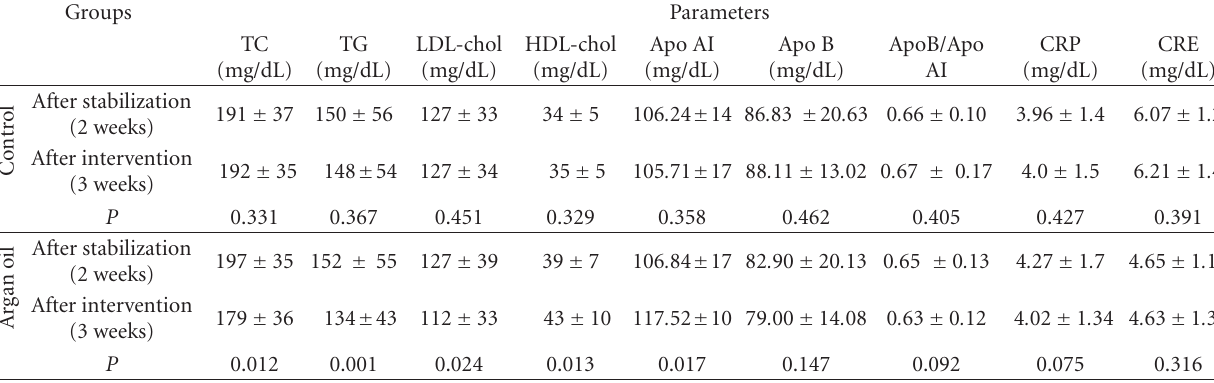
Table 3: Variations of di ff erent parameters in both groups after three weeks of intervention.